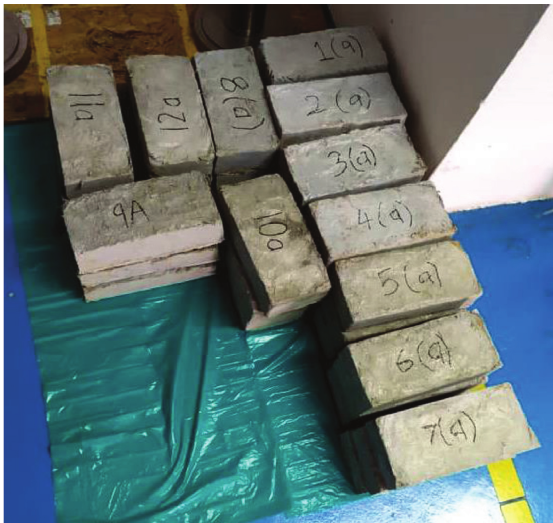
Figure 2: Brick samples of different CNS content. Table 3: Mix proportions of the